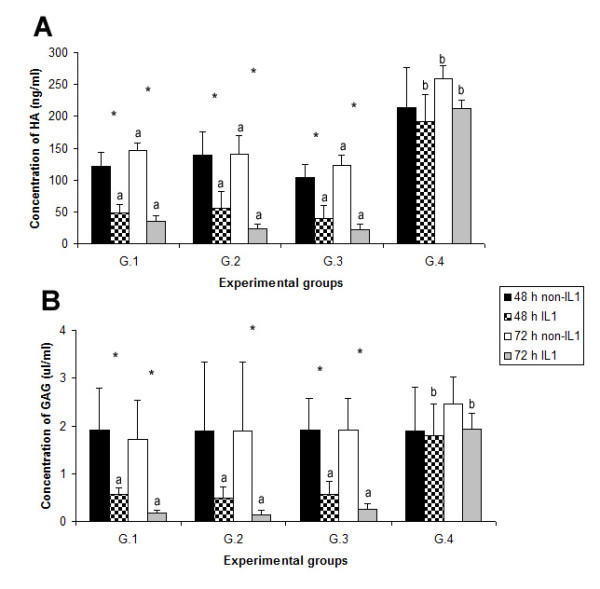
Levels of hyaluronan (HA) and glycosaminoglycan (GAG) in all experimental groups. Individual bars show the mean ± SD. A significant difference (p < 0.05) between the four groups at the same condition (48 h non-IL1, 48 h IL1, 72 h non-IL1 and 72 h IL1) is displayed with superscript (a, b) on the bars. A significant difference (p < 0.05) between treatment and non-treatment with IL-1β at the same period (48 or 72 h) is displayed with superscript (*) on the bars. G1 = control group; G.2 = solution control; G.3 = non-silencing siRNA; and G.4 = MMP-3 siRNA.